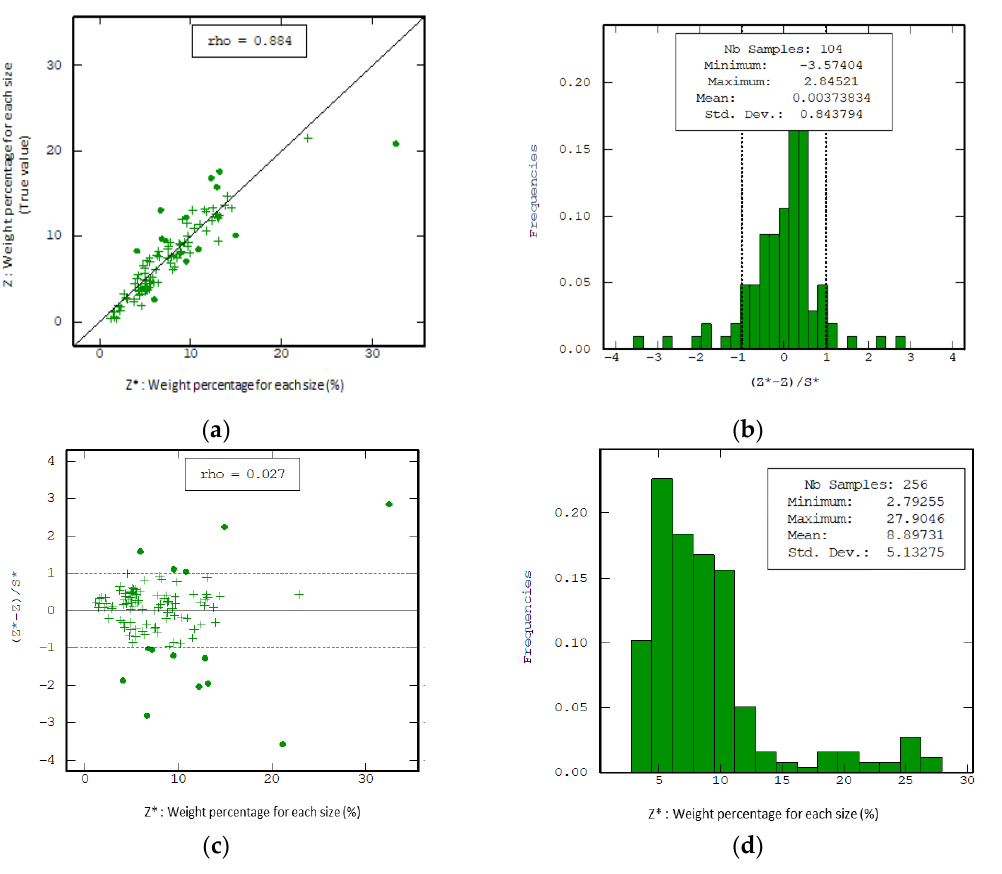
Figure A7. Cross-evaluation of the geostatistical analysis of LGP-3 with ore-A. ( a ) Scatter plot (identity line) where the x-axis represents modeled data, and the y-axis represents the experimental data. ( b ) Standardized error histogram. ( c ) Standardized error based on the estimated value. ( d ) Histogram and its statistical parameters of the estimated data.